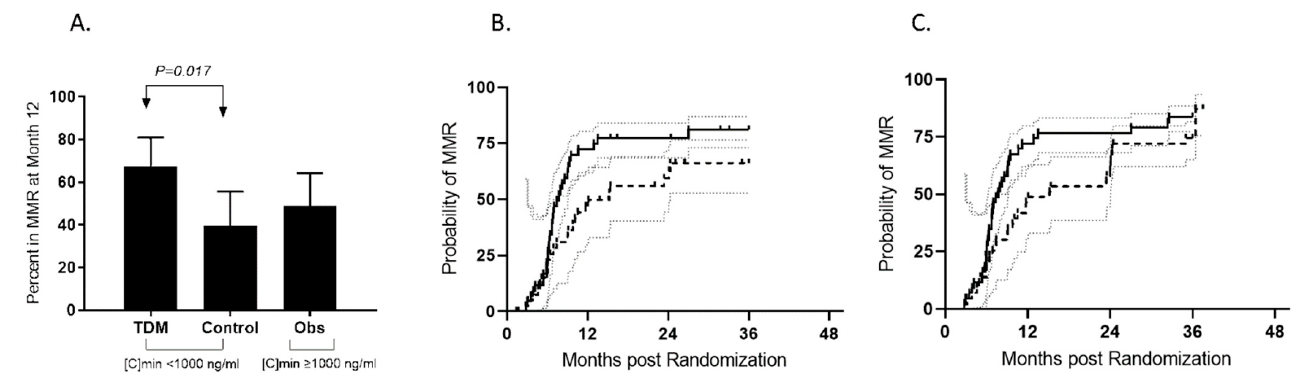
Figure 2. Major molecular response rates at 12 months ( A ) and by 36 months ( B , C ). ( A ) Twenty-nine patients (67% (95% CI, 51–81)) achieved MMR at month 12 in the TDM arm, as opposed to 39% (95% CI, 24–55) in the control arm ( p = 0.017) (dark plots). The rate of MMR was 49% (95% CI, 34–64) for patients included in the observational arm (dark plots). TDM: therapeutic drug monitoring arm, MMR: major molecular response (dark plots), no MMR: grey plots, [C)min: trough imatinib plasma level at inclusion. ( B ) Cumulative incidence of MMR in both the TDM arm (continuous line) and the control arm (dashed line) during the 36-month study period. Patients were censored in case of imatinib cessation (as is usual for studies comparing imatinib and second-generation tyrosine kinase inhibitors [6–8]). ( C ) The cumulative incidence of MMR in both the TDM arm (continuous line) and the control arm (dashed line) during the 36-month study period. Patients were not censored in case of imatinib cessation.